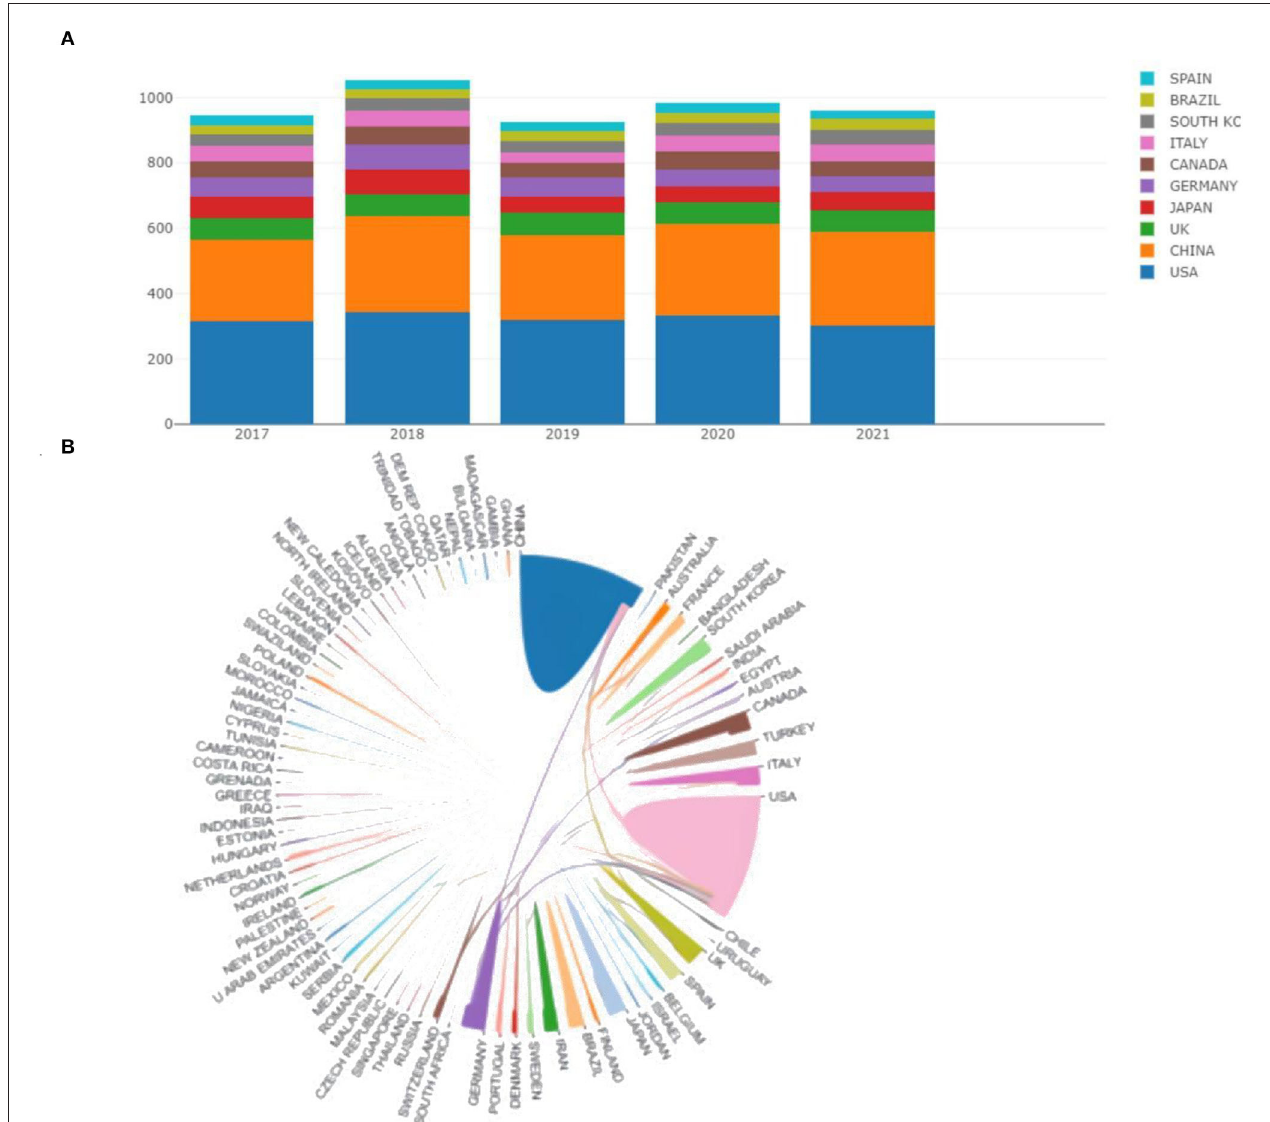
FIGURE 2 | (A) The annual publication counts of the top 10 countries from 2017 to 2021. (B) Collaboration analysis among different